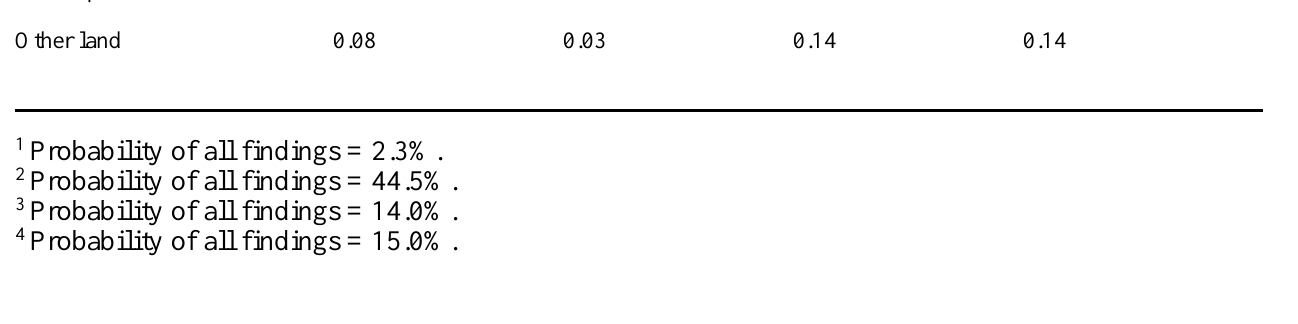
Table 6. Inference results of Model 1(LCA). Land cover of Scotland LCA = 2 1 LCA = 3 2 LCA = 4 3 LCA = 5 4 Arable land 0.60 0.62 0.18 0.07 Improved grassland 0.10 0.17 0.28 0.11 Rough grazing 0.07 0.04 0.12 0.14 Forest 0.08 0.07 0.26 0.40 Developed rural 0.07 0.06 0.01 0.01 Other land 0.08 0.14